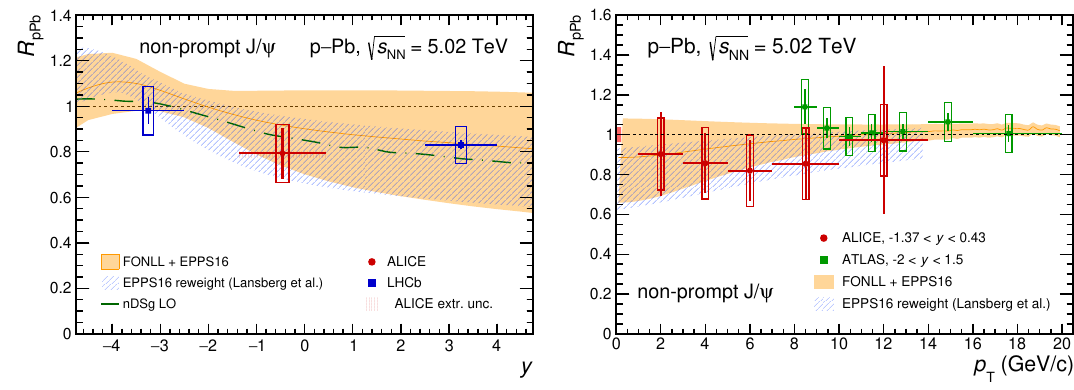
Figure 8 . Nuclear modification factor R of non-prompt J /ψ as a function of rapidity (left pPb panel) and as a function of p at midrapidity (right panel). The results are compared with similar T measurements from the LHCb [64] and ATLAS [14] experiments. Vertical bars and the open boxes indicate the statistical and systematic uncertainties, respectively. The uncertainty due to the ex- trapolation to p = 0 GeV/ c for the ALICE measurement is reported as a shaded box in left panel, T while the filled box around R = 1 in the right-hand panel denotes the size of the global normali- pPb sation uncertainty. The predicted nuclear modification factors according to the nDSg [109] (central value shown in the left panel only) and EPPS16 [95] parameterisations (including a reweighted computation from [101]) are shown superimposed on both